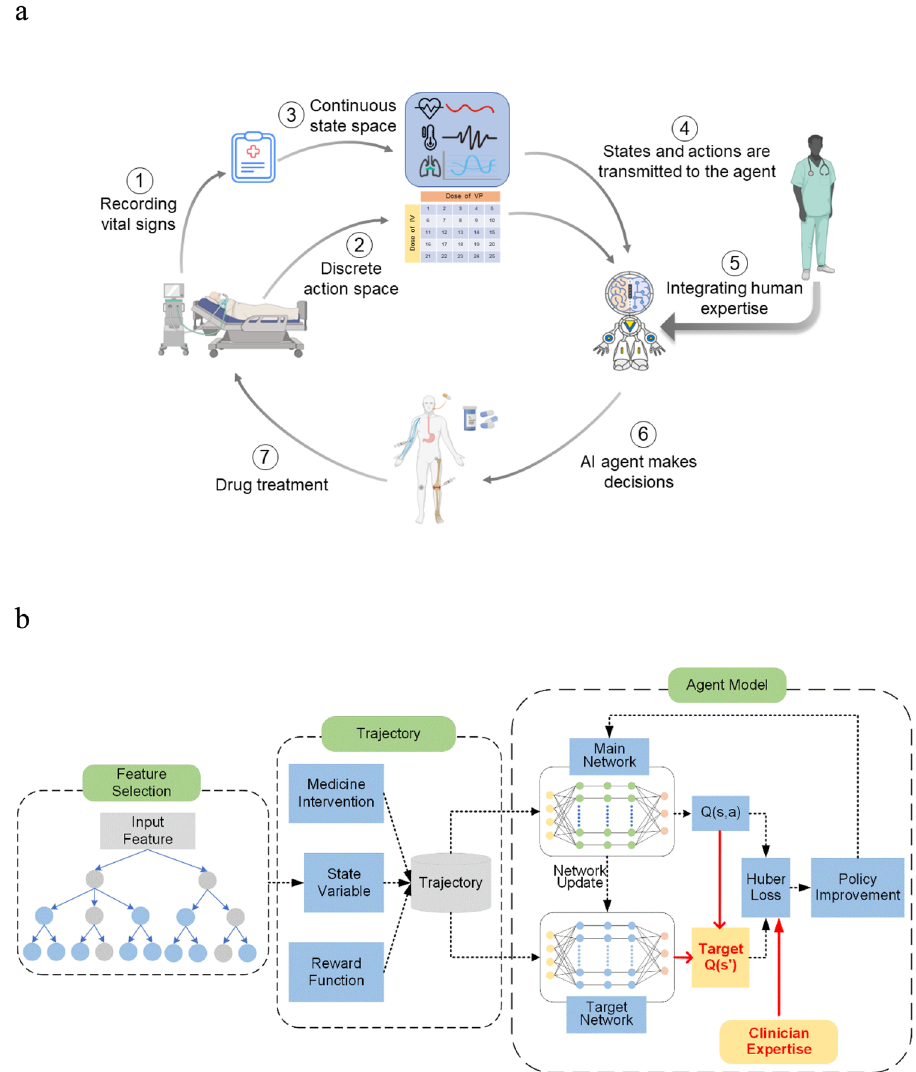
Fig. 1 Architecture of WD3QNE algorithm. a The dynamic treatment process of the WD3QNE agent for sepsis. The continuous state space and discrete action space are then constructed. The DRL agent takes actions based on the current state and clinician expertise. b WD3QNE algorithm